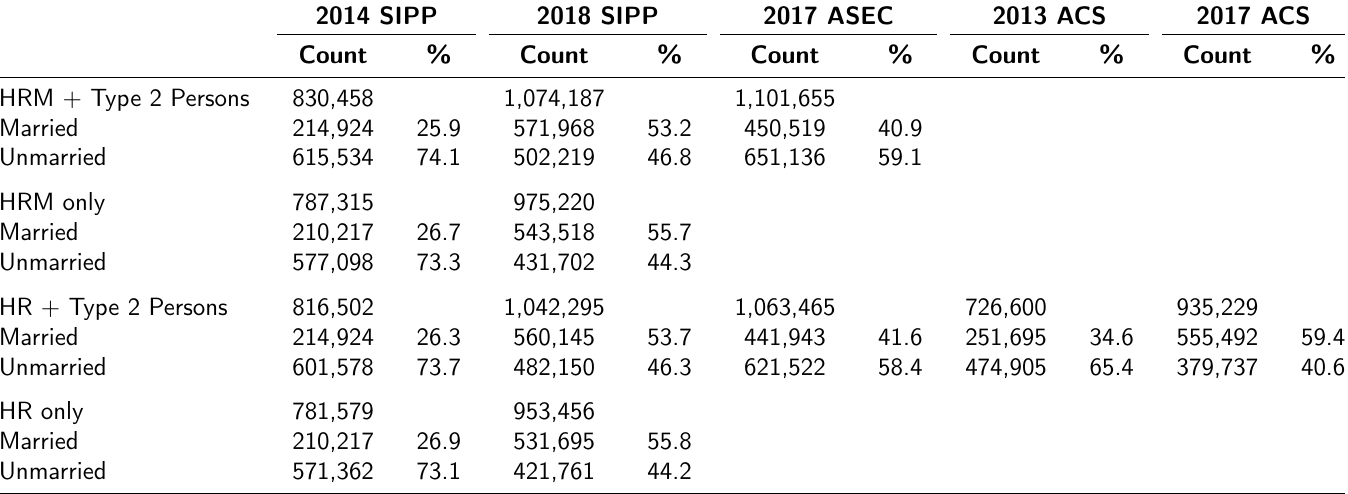
Table 2: Estimated counts of households with same-sex couples, by counting method and relationship